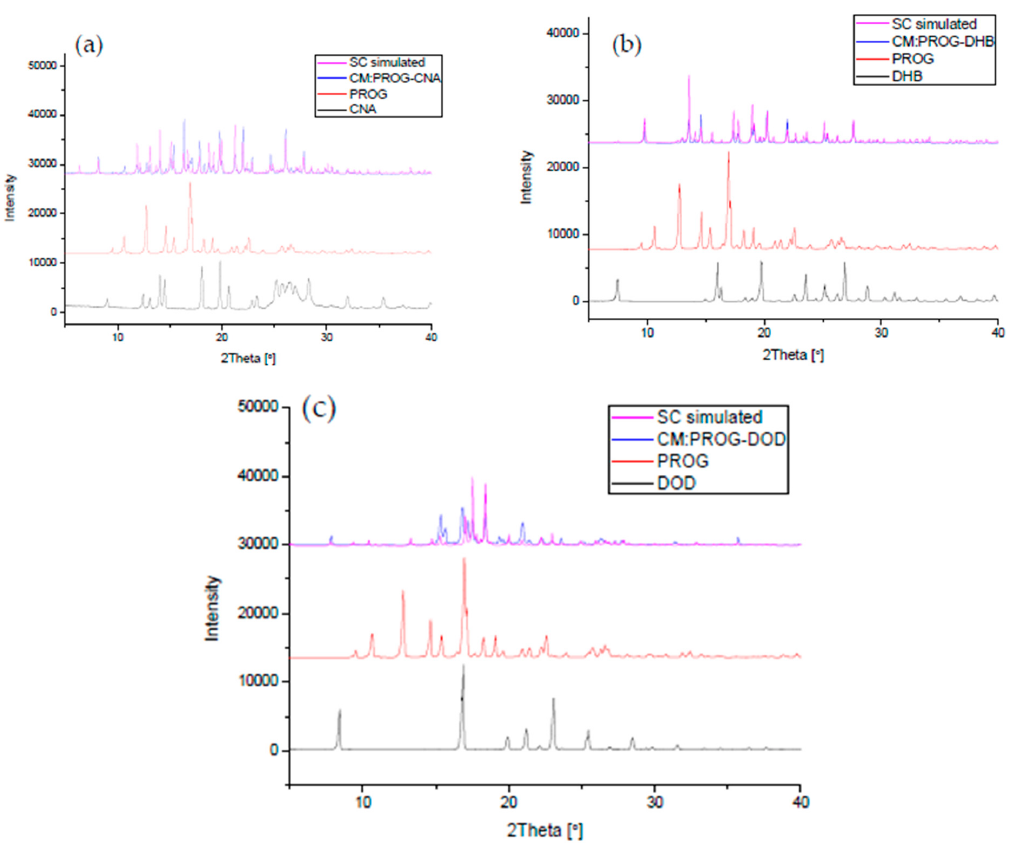
Figure 6. Combined simulated and experimental PXRD patterns of the co-crystals, PROG, and the CCFs: ( a ) PROG-CNA, PROG, and CNA; ( b ) PROG-DHB, PROG, and DHB; and ( c ) PROG-DOD,